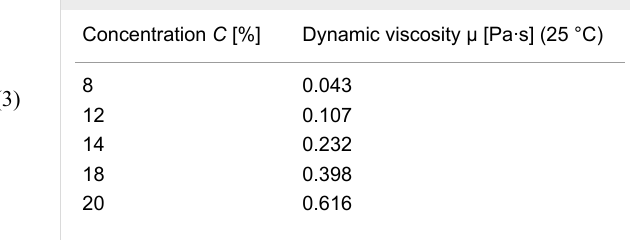
Table 1: Dynamic viscosity of polyvinylpyrrolidone (PVP)